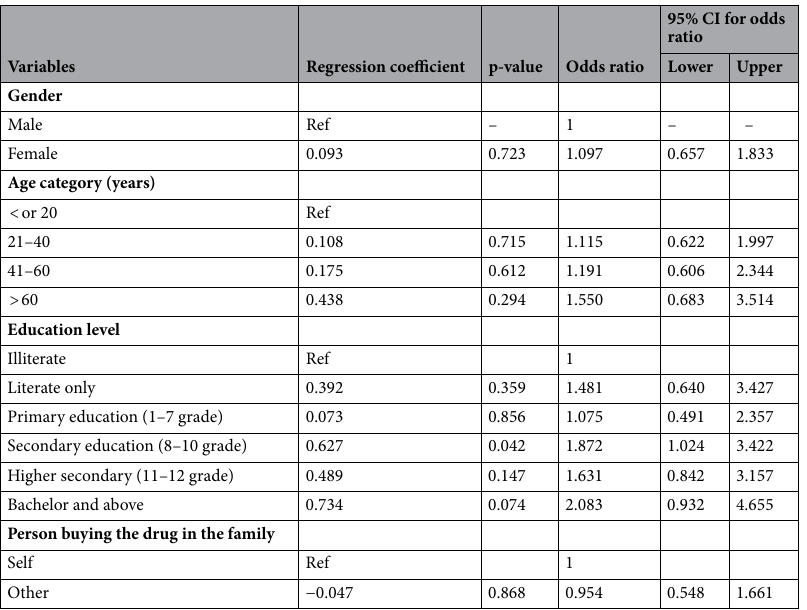
Table 2. Multivariate analysis of predictors of knowledge on